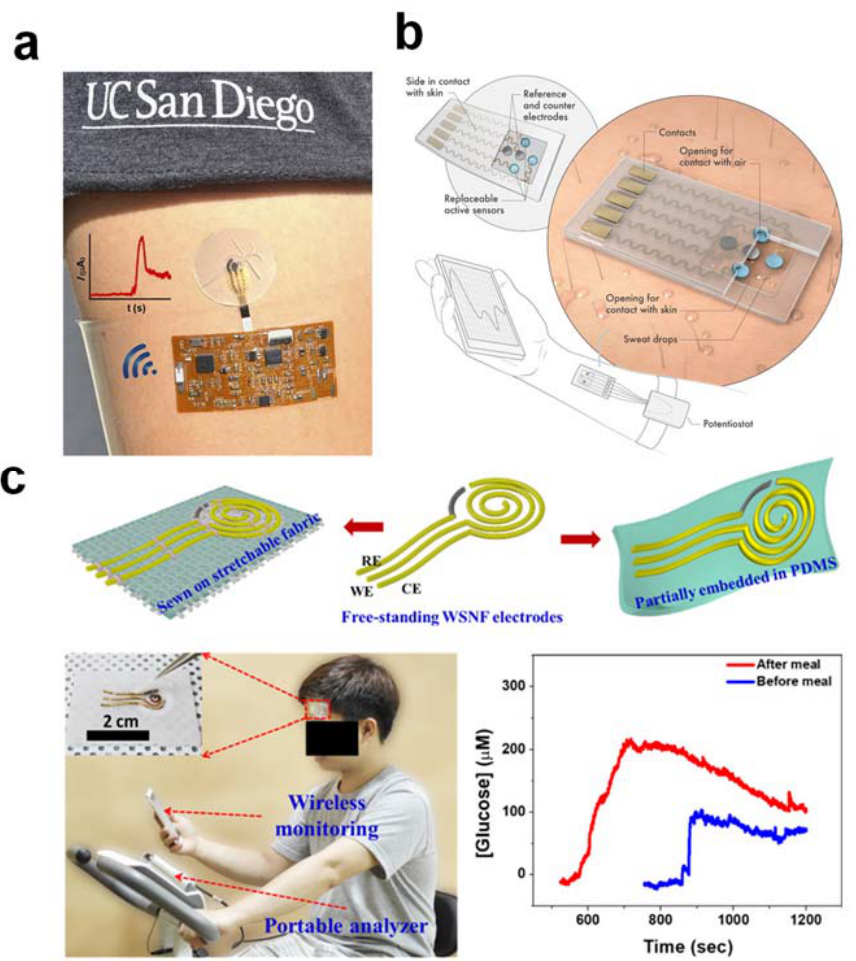
Figure 2. ( a ) Epidermal electrochemical detection system integrated with conformal wireless elec- tronics on the skin. ( b ) A wearable biosensor system based on MXene (a three-phase oxygen-rich electrode design) is depicted schematically. ( c ) A wrinkled, stretchable, nanohybridfiber glucose sensor for continuous on-body monitoring before and after meals of glucose levels in sweat. The figures are reprinted with permission from ref [17,18,21].